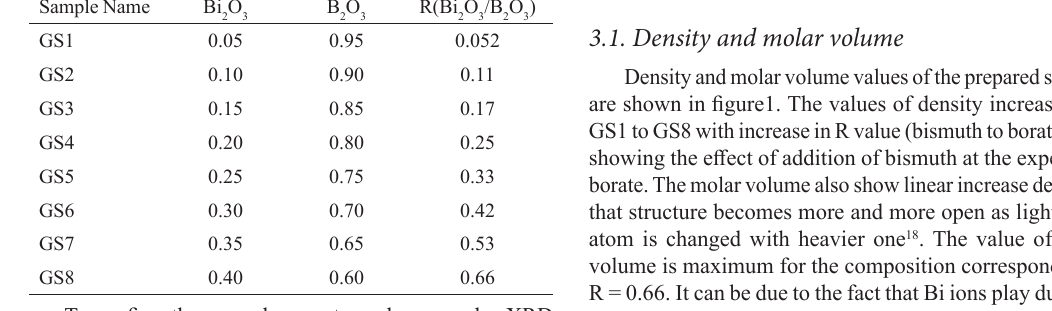
where f = n / ∑n is fractional abundance of element i i i j with respect to number of atoms and Z of i